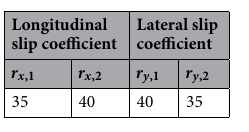
Table 4. Tire combined slip